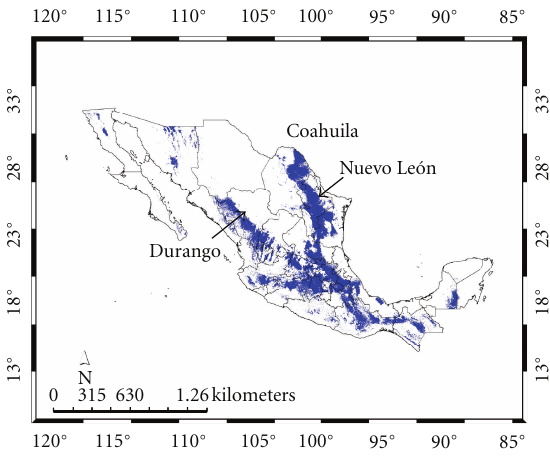
Figure 5: Species distribution model and Mexican states for the Ixodes group. The principal states are shown (see text).